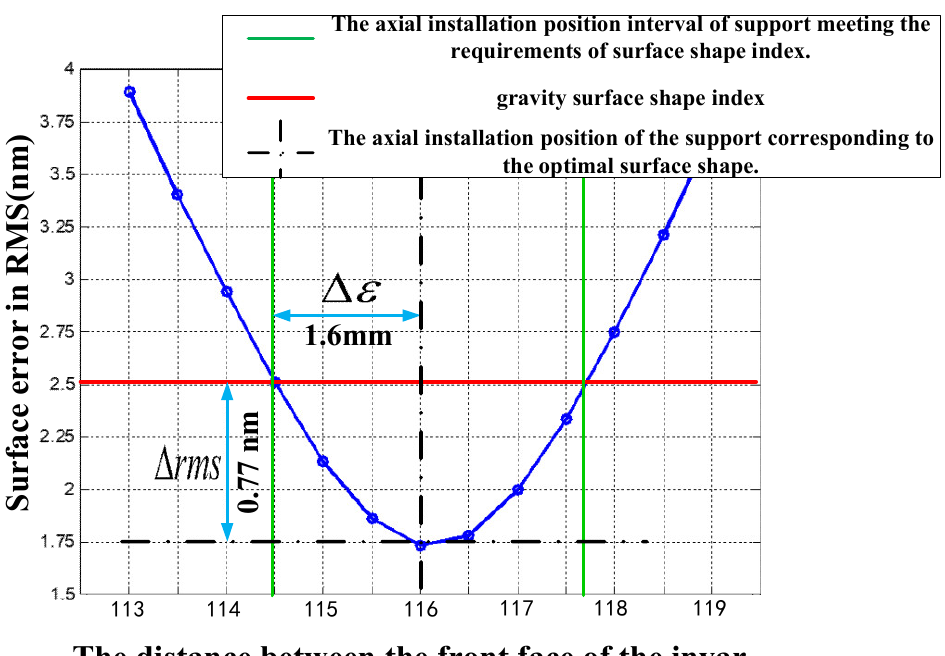
Figure 5. Trend of distortions depending on axial location of supports, also showing the optimal surface accuracy, flexure accuracy (green line) and gravity surface accuracy index (red line).